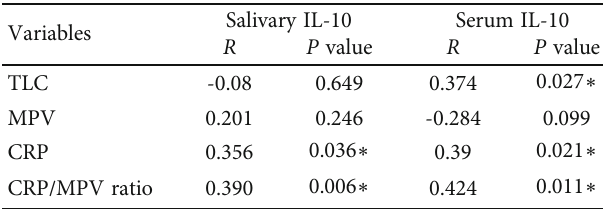
Figure 2: Salivary and serum IL-10 in discrimination of serum CRPvalues > 10 mg/L . Table 4: Correlation between salivary and serum IL-10 and other laboratory